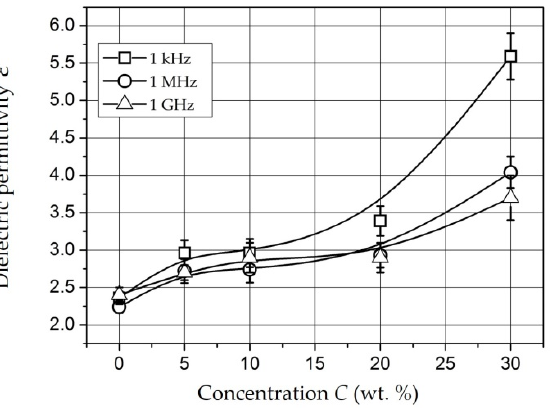
Figure 10. Dependence of dielectric permittivity ε on concentration of NiFe 2 O 4 nanoparticlesat a frequency of 1 kHz (squares), 1 MHz (circles), and 1 GHz (triangles) [151].